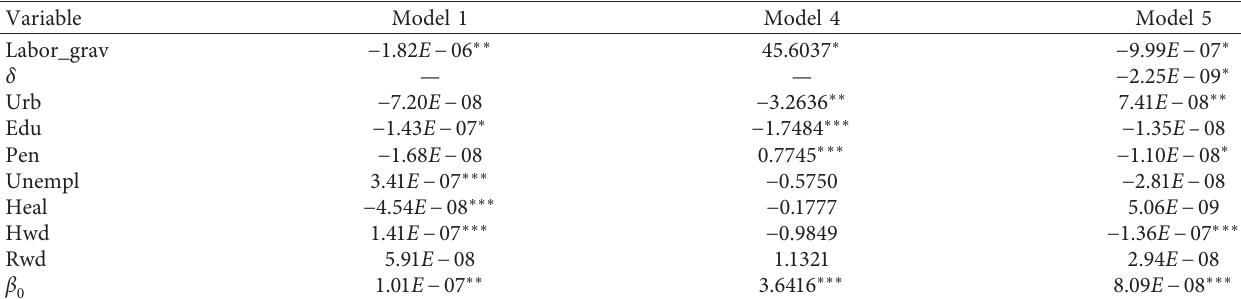
Table 6: The estimation results of 25 provinces and the leapfrogging index is the mediator variable. Variable